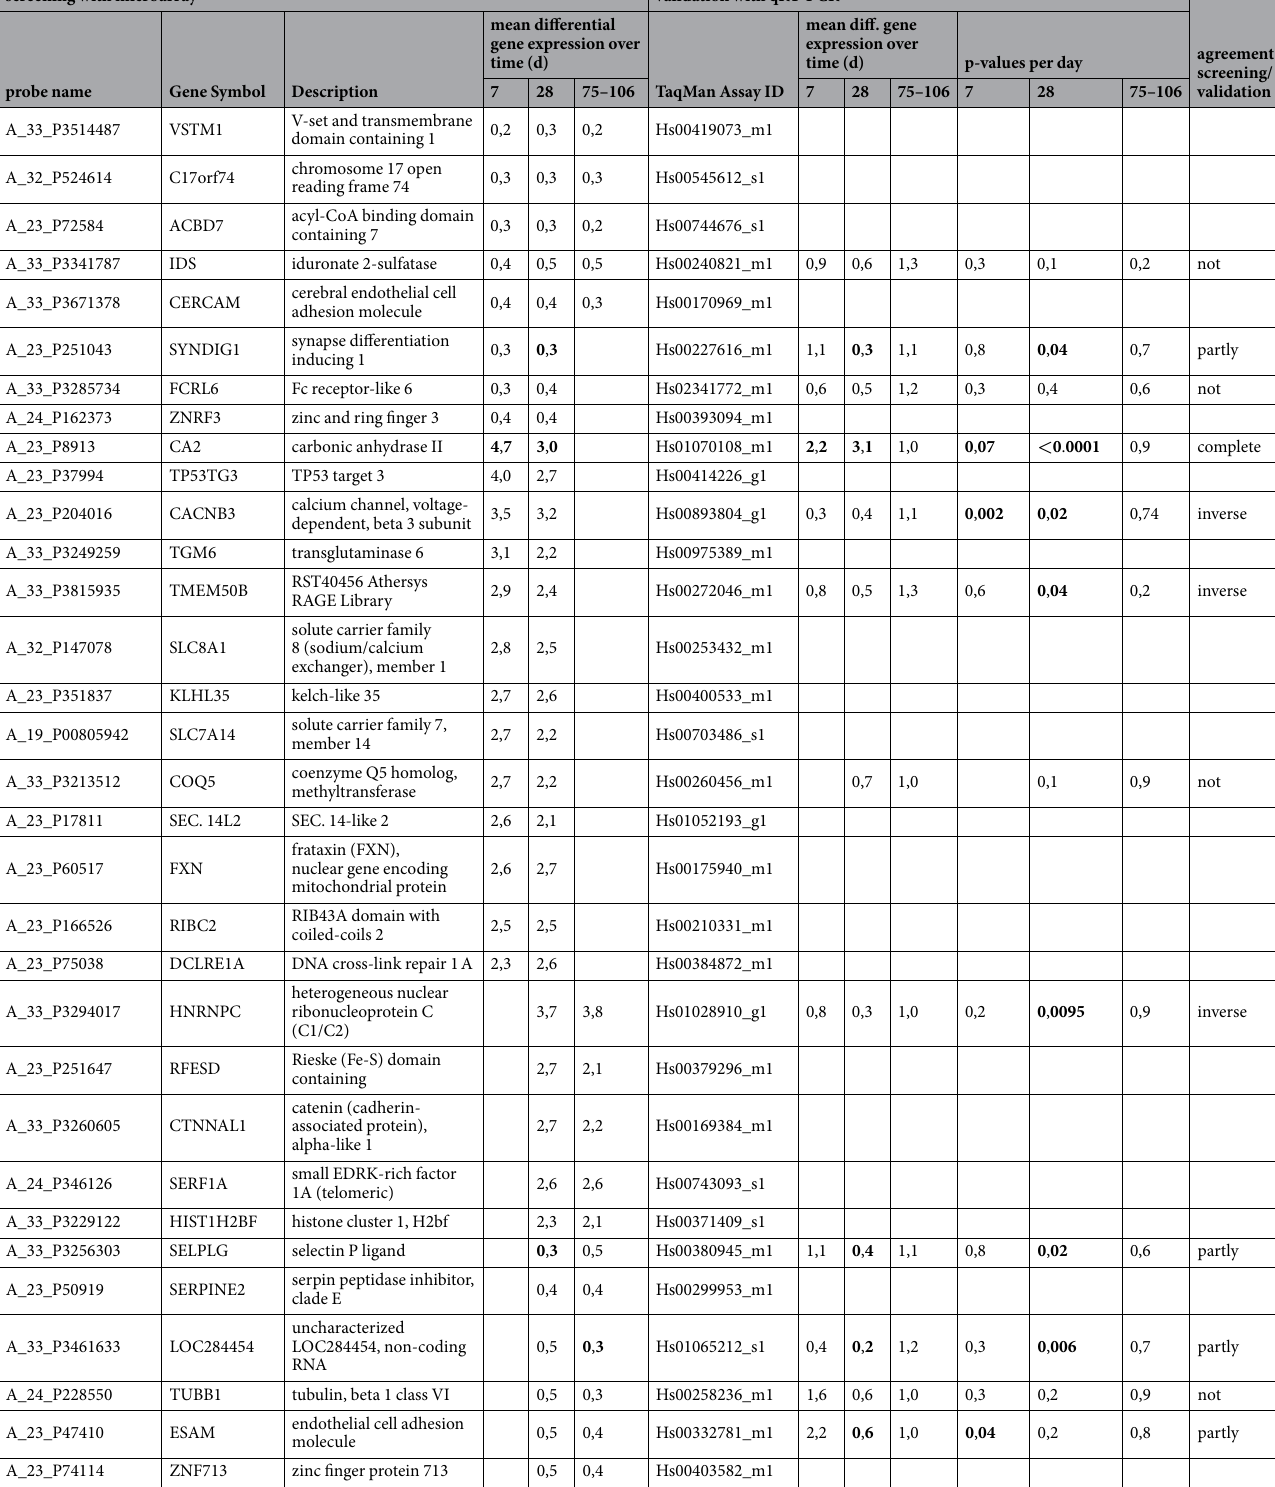
Table 2. The left part of the table summarizes results from the screening stage for differentially expressed mRNAs over time using microarrays. The right part of the table shows the results from the validation stage. In total 32 candidate genes from screening were validated employing a specific primer-probe design (TaqMan Assay ID). Differential gene expression (fold changes relative to unexposed controls) and corresponding p-values are shown per day for each mRNAs where amplification plots were developed in ≥ 60% of the examined samples. Fold-changes in gene expression and associated p-values that showed successful